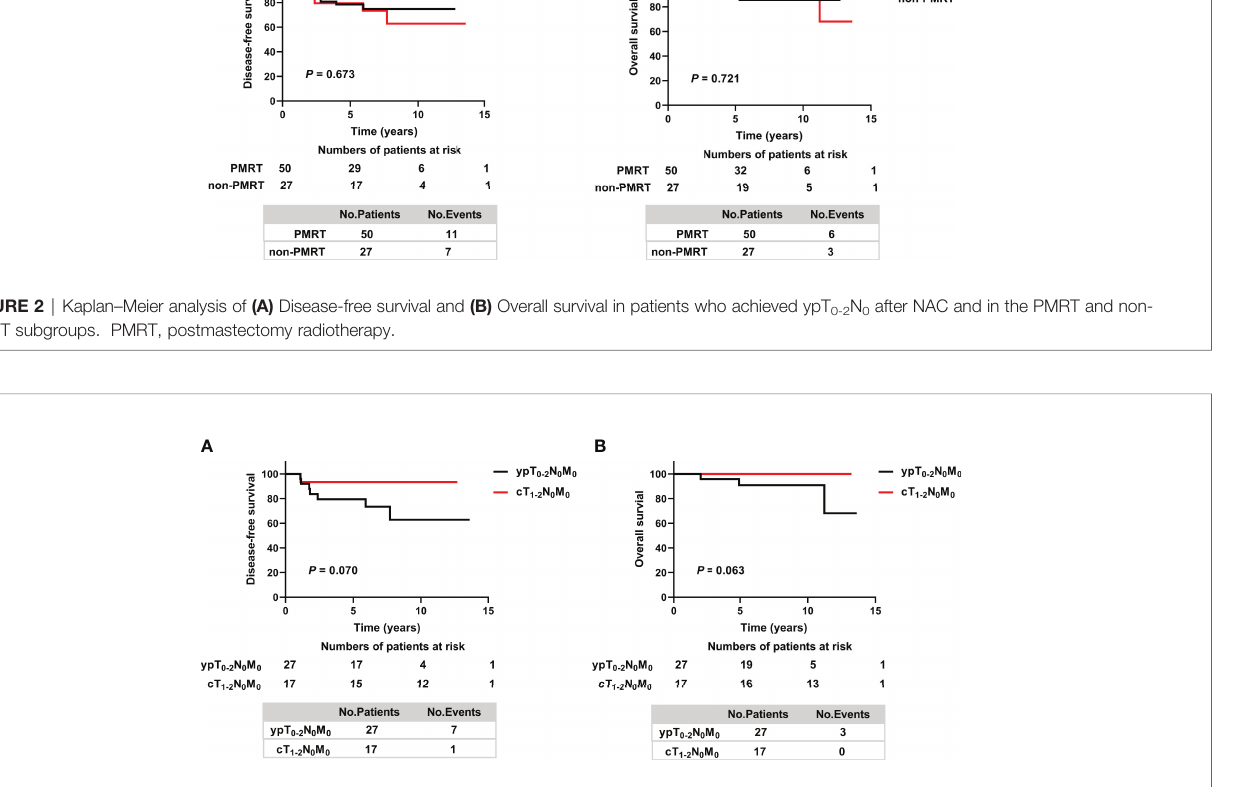
FIGURE 3 | Kaplan – Meier analysis of (A) Disease-free survival and (B) Overall survival in cT 1-2 N + patients who achieved ypT 0-2 N 0 after NAC without PMRT and cT 1-2 N 0 non- PMRT patients. ypT, pathologic tumor size after neoadjuvant therapy; ypN, pathologic lymph node after neoadjuvant therapy; cT, clinical tumor size; cN, clinical lymph